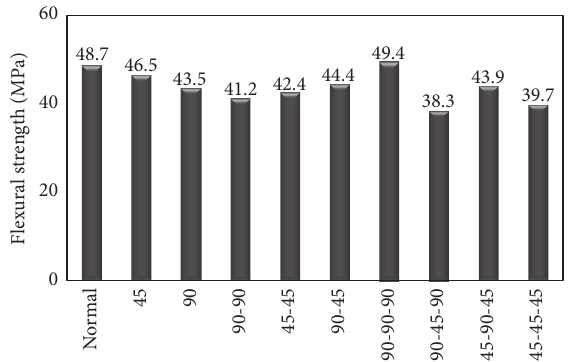
Figure 8: Flexural strength of the BFRP HPFRCC beam.